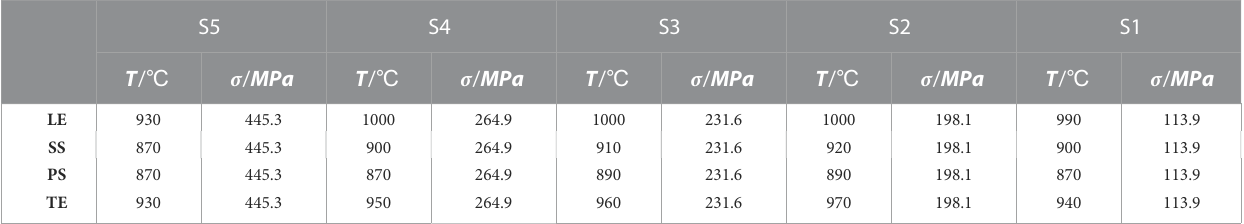
TABLE 2 Temperature and stress at different locations of the